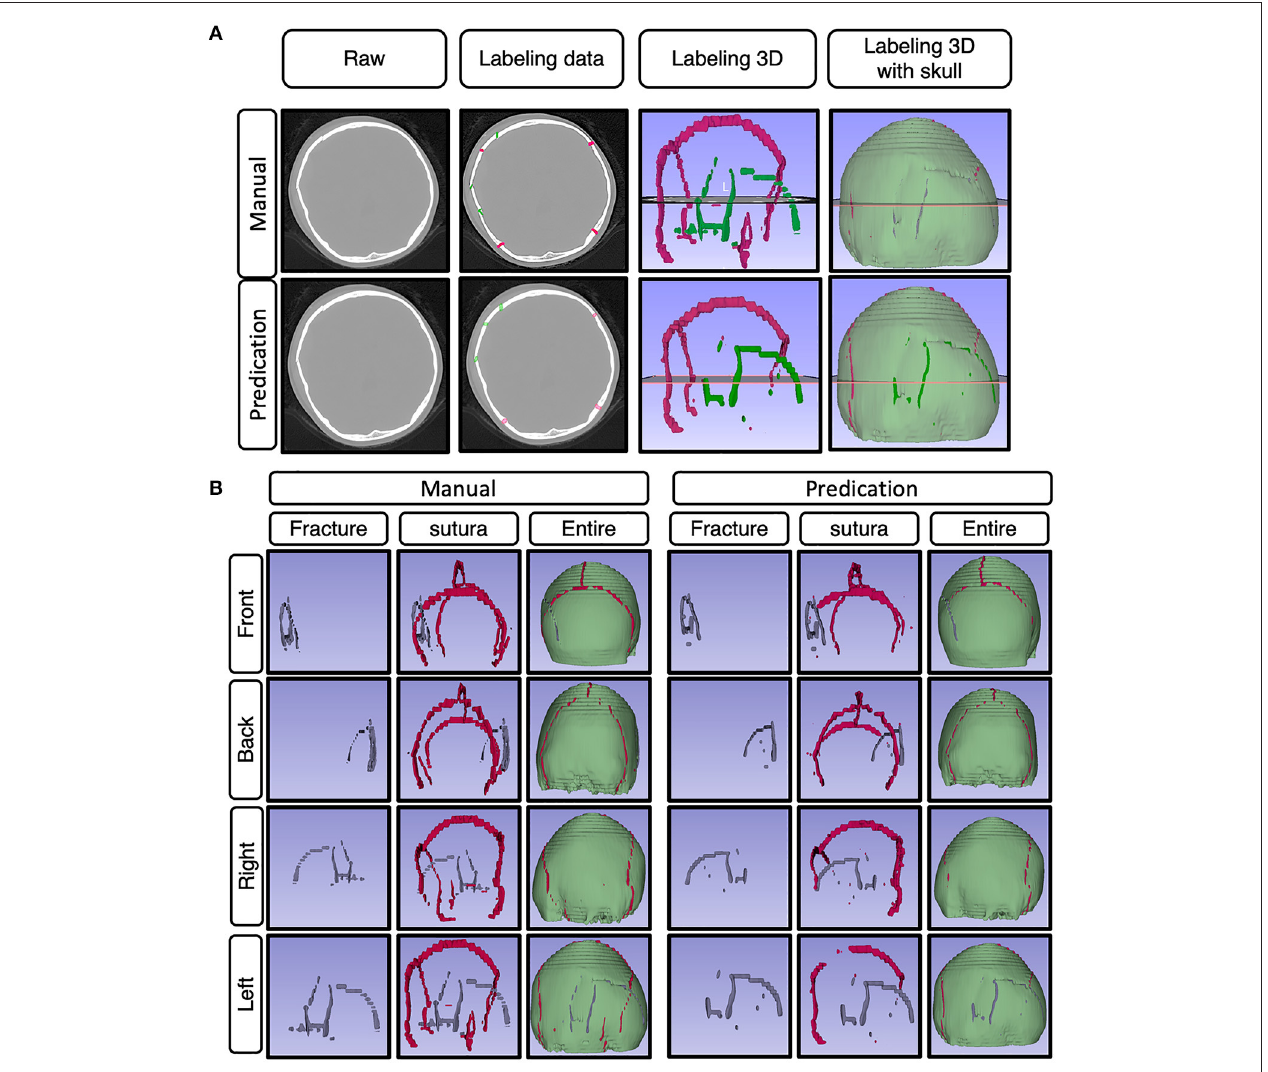
FIGURE 6 | Represented images for the demo case. (A) Representative images showing the raw data of skull fractures based on CT bone algorithm sequence slices, manual skull fracture labeling, 3-D reconstruction images of sutura and fracture, and 3-D reconstruction images of sutura, fracture, and whole skull. (B) The represented images show the demo case from a 3D perspective (front, back, right side, left side), with manually labeled images and predication-labeled images.